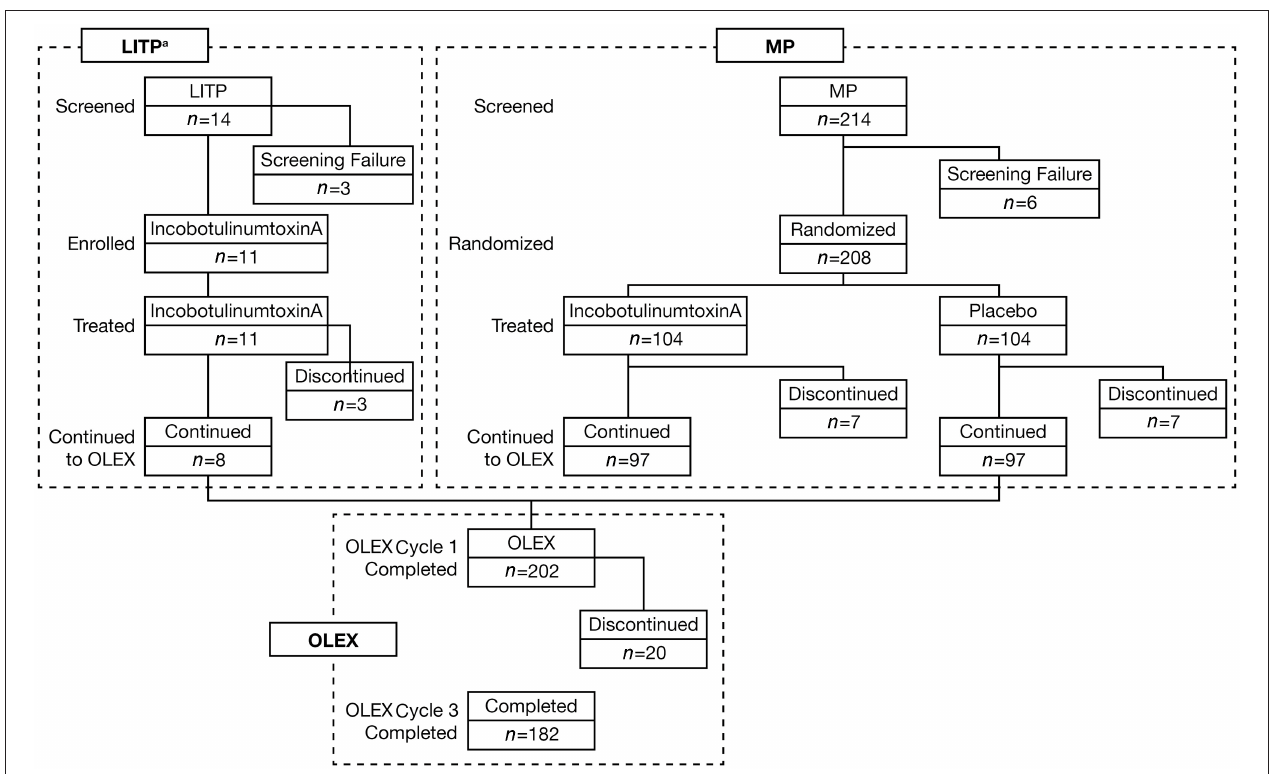
FIGURE 2 | Subject disposition. a The LITP was performed before the MP. LITP, lead-in tolerability period; MP, main period; n , number of subjects at each stage; OLEX, open-label extension period.